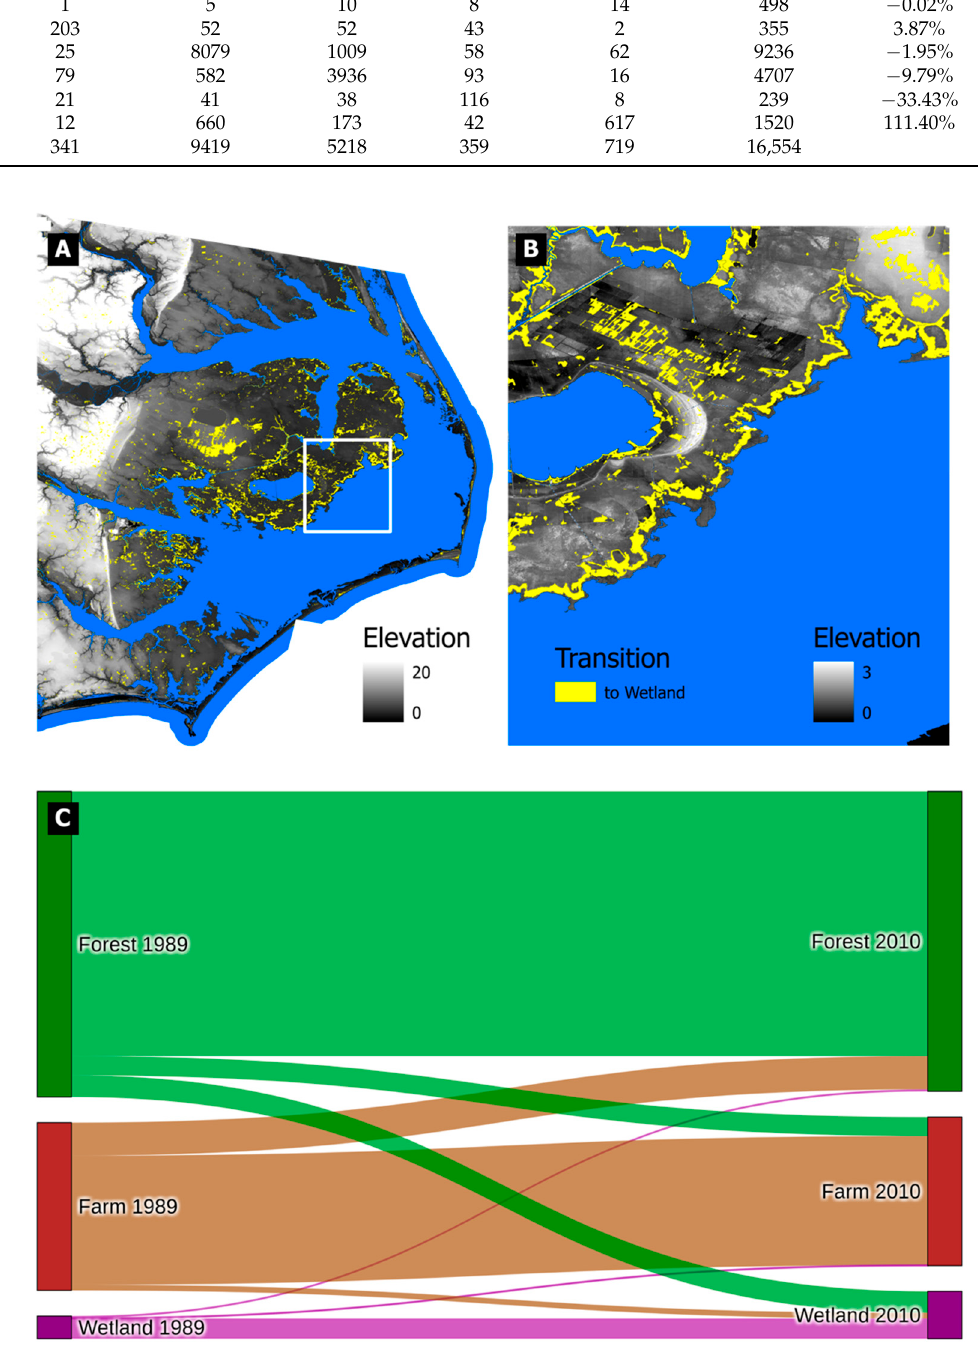
Figure 7. Final output land cover classes from the recurrent convolutional neural network in 1989 (panel A) and 2011 (panel D ). The zoomed region in panels ( B , E ), ( C , F ) is denoted by the white rectangle in panel ( D ). Panel ( E ) shows the creep of wetland inland. Panel ( E ) also shows the large number of pixels that changed to wetland and appear to be along field boundaries as well as ditches and canals that provide connectivity to saltwater. Panels ( C , F ) show Landsat imagery from the spring of the 1989 and 2011, respectively, visualized in false color as NIR-R-G for comparison with model output.